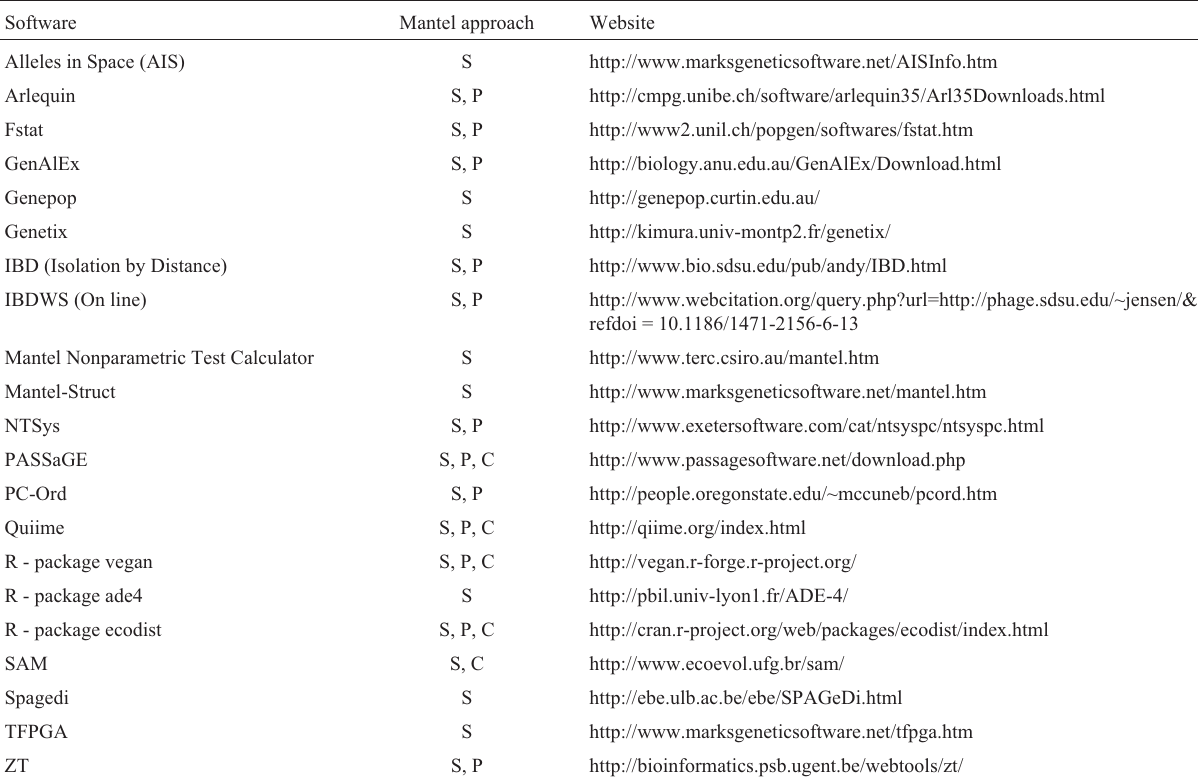
Table 1 - Some of the softwares available for different approaches based on Mantel tests, including simple Mantel test (S), partial Mantel tests (P) and correlograms (C), and the website where they can be found.